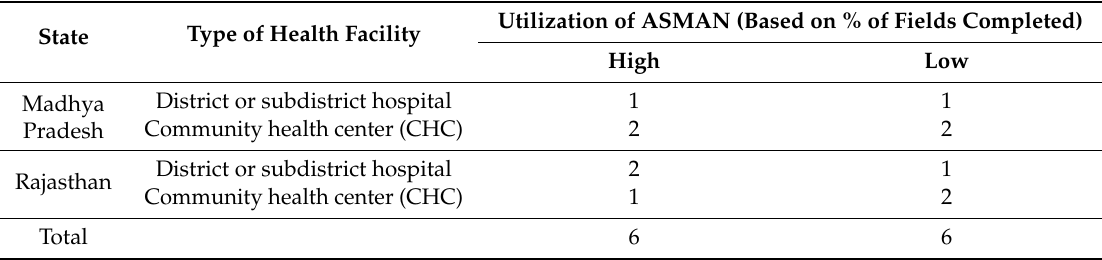
Table 1. Number of facilities in study sample by state, type of facility, and utilization